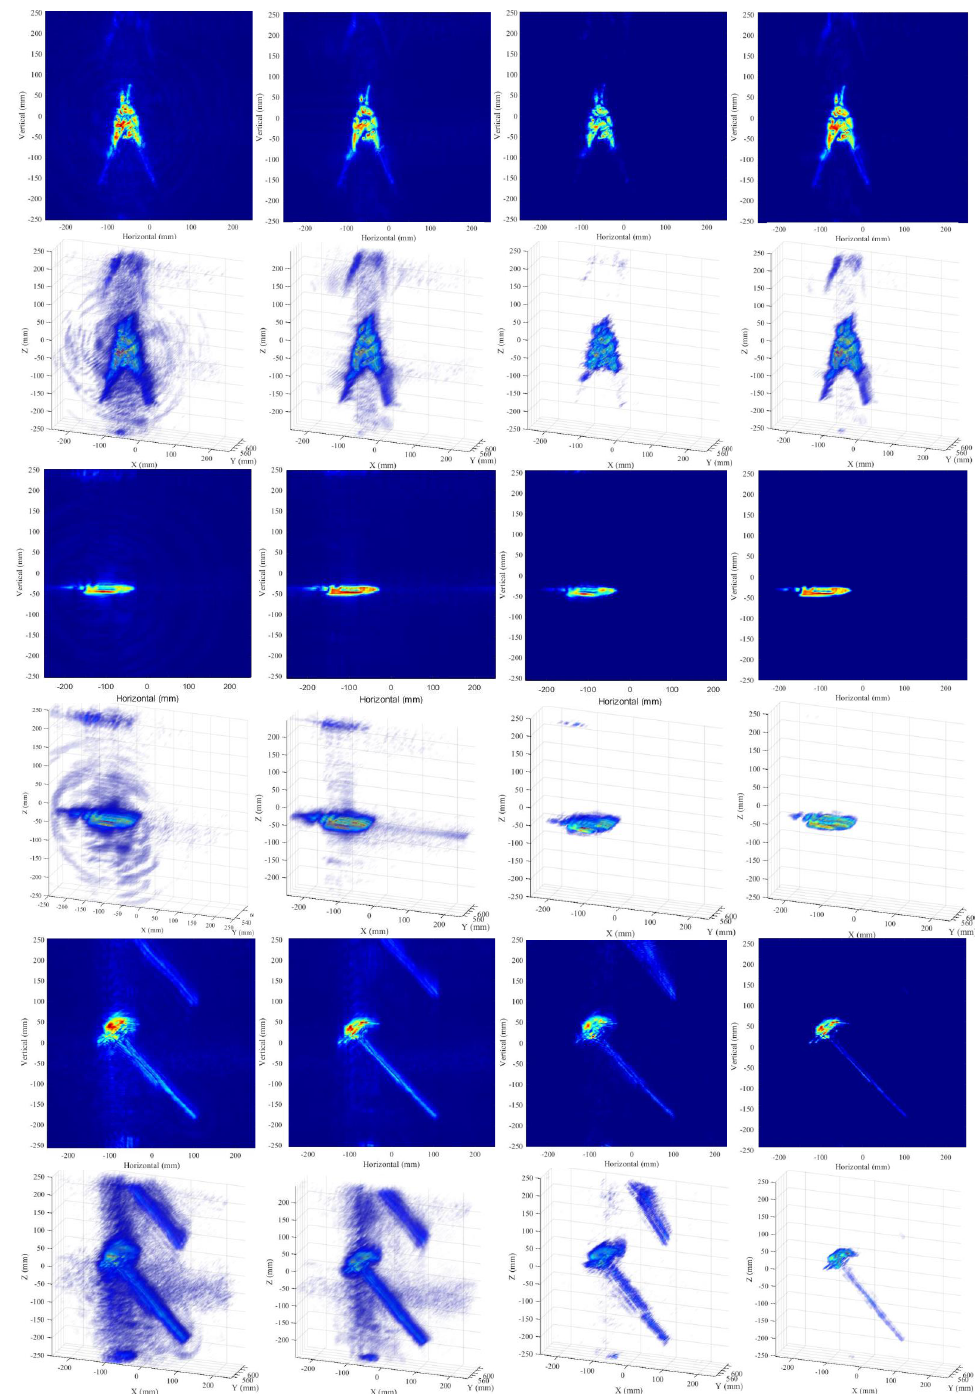
Figure 12. Imaging results of different targets using different algorithms. (Rows 1, 2) are the results of a plier; (Rows 3, 4) are the results of a stiletto; (Rows 5, 6) are the results of a hammer. Rows 1,3, and 5 are the 2-D imaging results; Rows 2,4, and 6 are the 3-D imaging results; Column 1 is the BPA imaging results; Column 2 is the RMA imaging results; Column 3 is the CSA imaging results; Column 4 is the RMIST-Net imaging